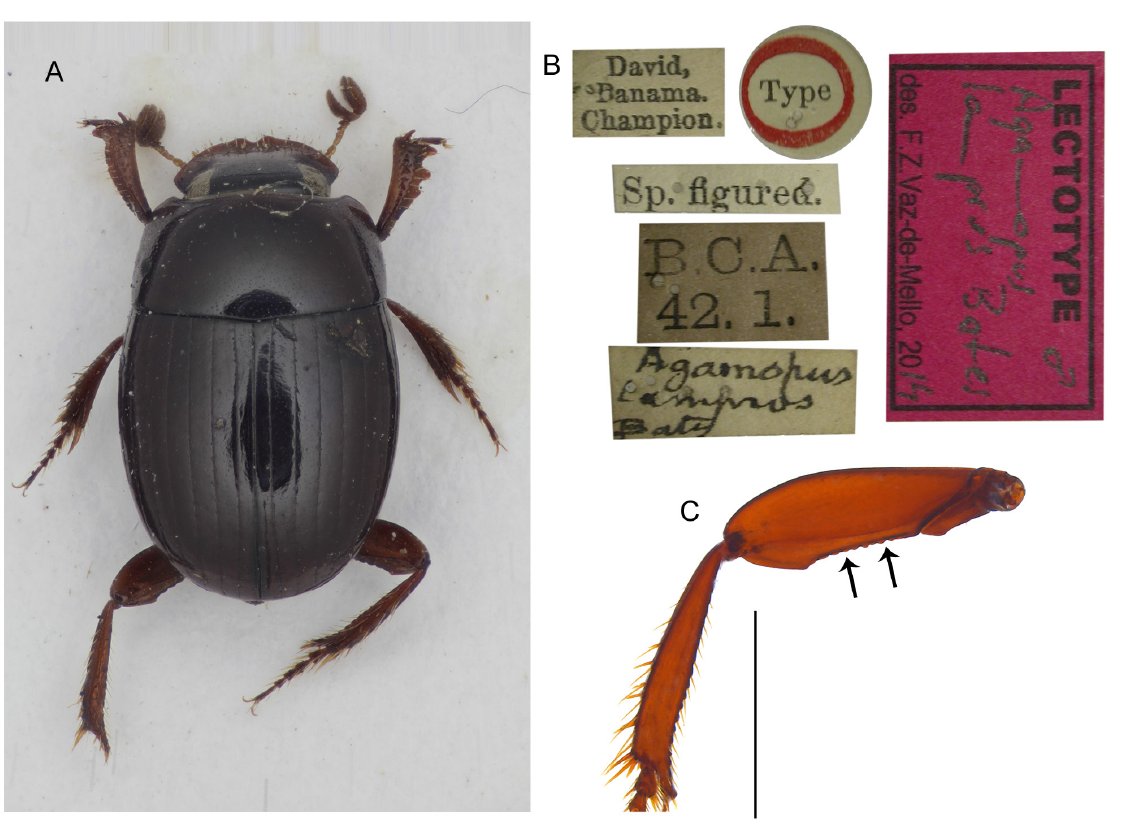
Fig. 6. Agamopus lampros Bates, 1887. A–B . Lectotype, ♂ (BMNH). A . Habitus, dorsal view. B . Labels. C . Hind leg of a non-type specimen (CEMT) showing the posterior femoral edge crenulate (black arrows). Length of specimen: 4.5 mm. Scale bar = 1